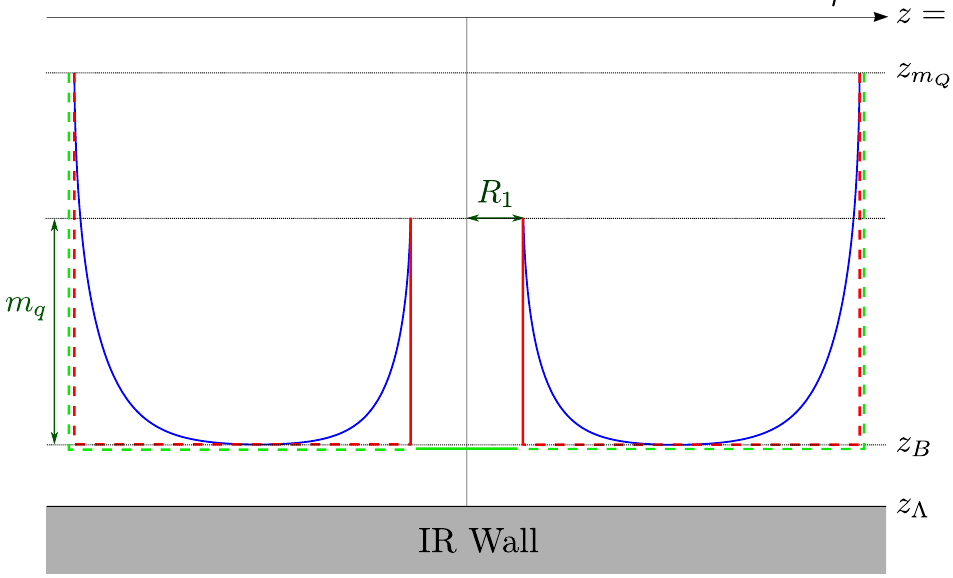
Figure 15 . U-shaped loop approximation (red rectangular straight lines for the double loop, green straight lines for the single loop which is to be subtracted). The dashed parts are the same for the single and double loop solutions. For comparison we have also displayed an actual solution (blue